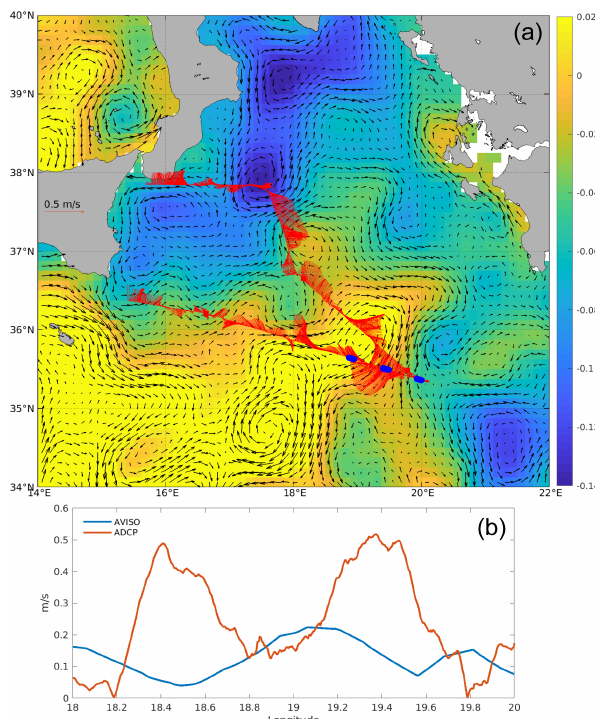
Figure 4. (a) Absolute dynamic topography (ADT, color) and sur- face geostrophic circulation from altimetry averaged over the period 22–30 May (black arrows). Underway ADCP currents are overlaid (red arrows). ION-Tr W, C and E are marked as blue dots as in Fig. 1. (b) Velocity along the ION-Tr transect derived from altime- try for 29 May and measured with ADCP.